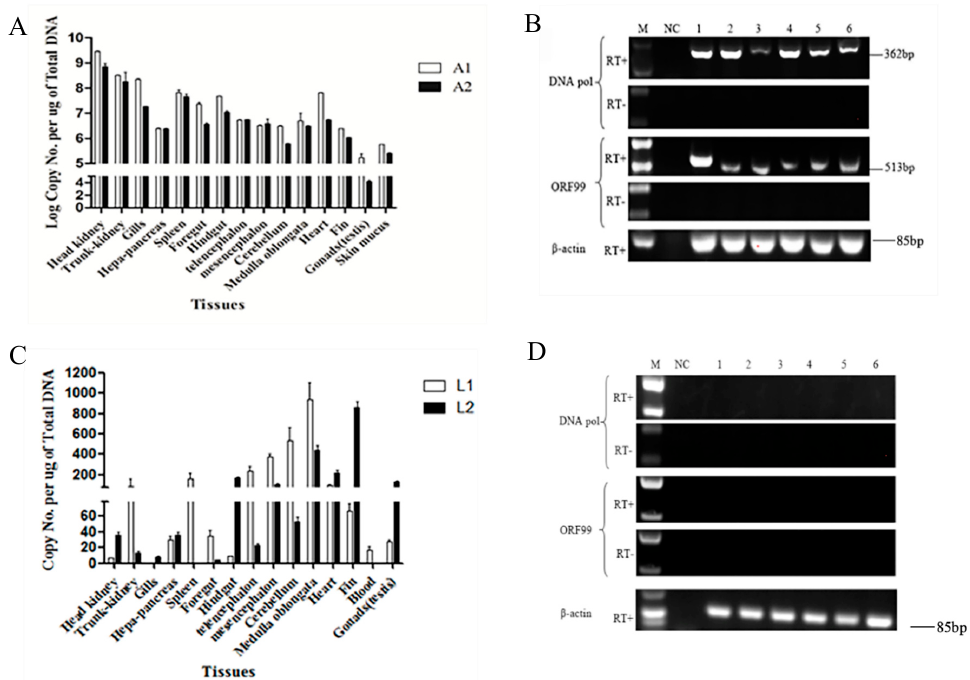
Figure 1. Detection of CyHV-2 DNA and gene transcription from moribund fish or surviving fish after primary infection with CyHV-2: Quantification of the CyHV-2 DNA in tissues from moribund fish ( A ) or surviving fish ( C ) by qPCR. White bars and black bars represent two moribund fish A1 and A2 in panel A and two surviving fish in panel C, respectively. CyHV-2 DNA copies were calculated according to the standard curve based on the series of diluted plasmids containing the DNA polymerase gene and were expressed as copies per µg of total DNA (copies/µg DNA). Data in A and C are presented as the mean of triplicates ± SD of each tested tissue sample from two representative fish. RT-PCR analysis of total RNA harvested from moribund fish ( B ) or surviving fish ( D ) tissues after primary infection with CyHV-2 in the presence (RT+) or absence (RT-) of reverse transcriptase: The amplicons of DNA pol (362 bp) and ORF99 (513 bp) are indicated. Lanes 1 to 6 represent the tissue of head-kidney, gills, midbrain, medulla oblongata, heart, and spleen, respectively. The amplicons of β -actin gene are used as an internal control to ensure that comparable levels of input RNA were used in RT-PCR. One representative experiment of three is shown.